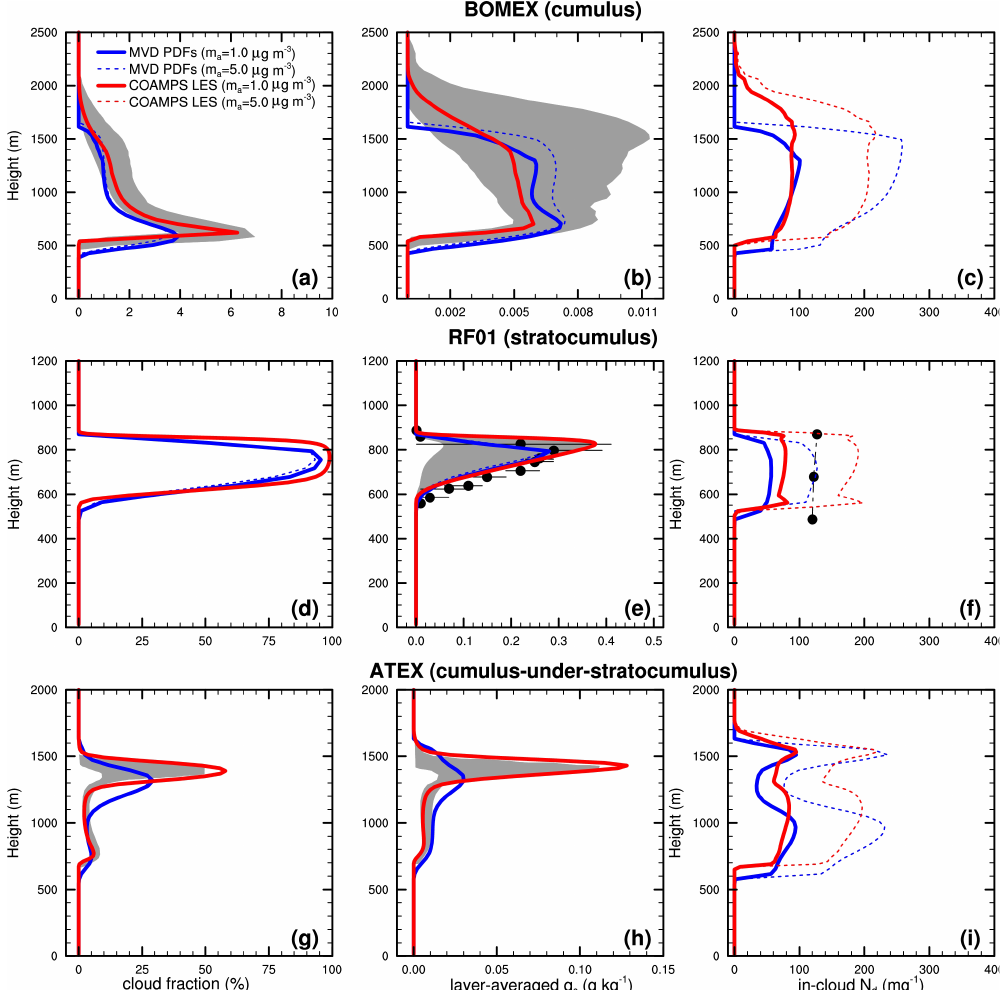
Fig. 2. Comparison of cloud fraction, layer-averaged cloud water content ( q c ), and in-cloud cloud droplet number concentration ( N d ) from the MVD PDFs (blue) and from COAMPS LES and S-S LES (red) at different sulfate concentrations ( m a ), averaged over the last 3h for BOMEX, last 2h for RF01, last 5h for ATEX, last 5h for RICO, and last 4h for RF02, corresponding to the periods for LES in Siebesma et al. (2003), Stevens et al. (2005), Stevens et al. (2001), Stevens and Seifert (2008), and Ackerman et al. (2009), respectively. The red solid and dotted curves are overlapped in (a) , (b) , (d) , (e) , (g) , and (h) because the microphysics was not considered in COAMPS LES following a protocol established by GCSS for non-precipitating clouds. Shaded areas indicate the upper and lower bounds of the LES ensemble. Dots in (e) indicate averages of observed q c , with horizontal bars indicating the first and third quartiles of the observed values (Zhu et al., 2005). Dots in (f), (l), (o) indicate averages of observed N d (vanZanten et al., 2005; Stevens and Seifert,